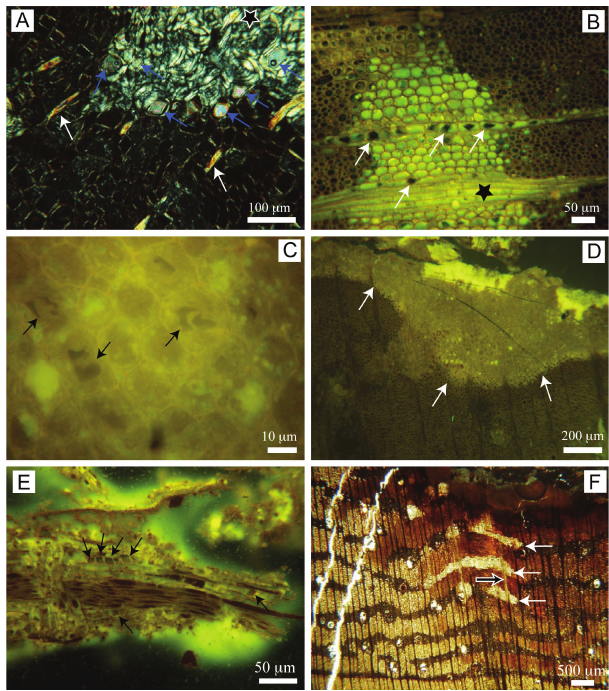
Fig. 3. (a) Optical cross-polarized light microscope observations. Bark tissues showing a silicification front (bright area, black star) developed among the parenchyma cells. Oxalate crystals (blue ar- rows) are embedded in the amorphous silica, which postdates the oxalatization. White arrows: phloem rays. (b–e) optical microscope observations under UV epifluorescence. (b) In the wood tissues, oxalate crystals (white arrows, dark shapes) are found in xylem rays (elongated structures). No oxalate crystal dissolution features have been observed. A calcitization phase is present (black star) in xylem rays and lateral cells of conductive vessels (the brighter area). Carbonate mineralization postdates the precipitation of ox- alate. (c) Thin section of wood tissues sampled close to a wound. Oxalate crystals show dissolution traits (black arrows). (d) Calciti- zation front (white arrows) close to a wound; open atmosphere is on the top righthand corner. In this particular case, dissolution features on oxalate crystals can be observed (see Fig. 3c). (e) Thin section of a decaying wood fragment shortly before release of oxalate crystals (black arrows). This sample is located in the first few centimetres of a soil profile. (f) Optical plane polarized light microscope obser- vation of wood tissues showing calcitized area (white arrows). Both xylem rays and conductive vessels are calcitized. The black arrow shows the calcitized xylem